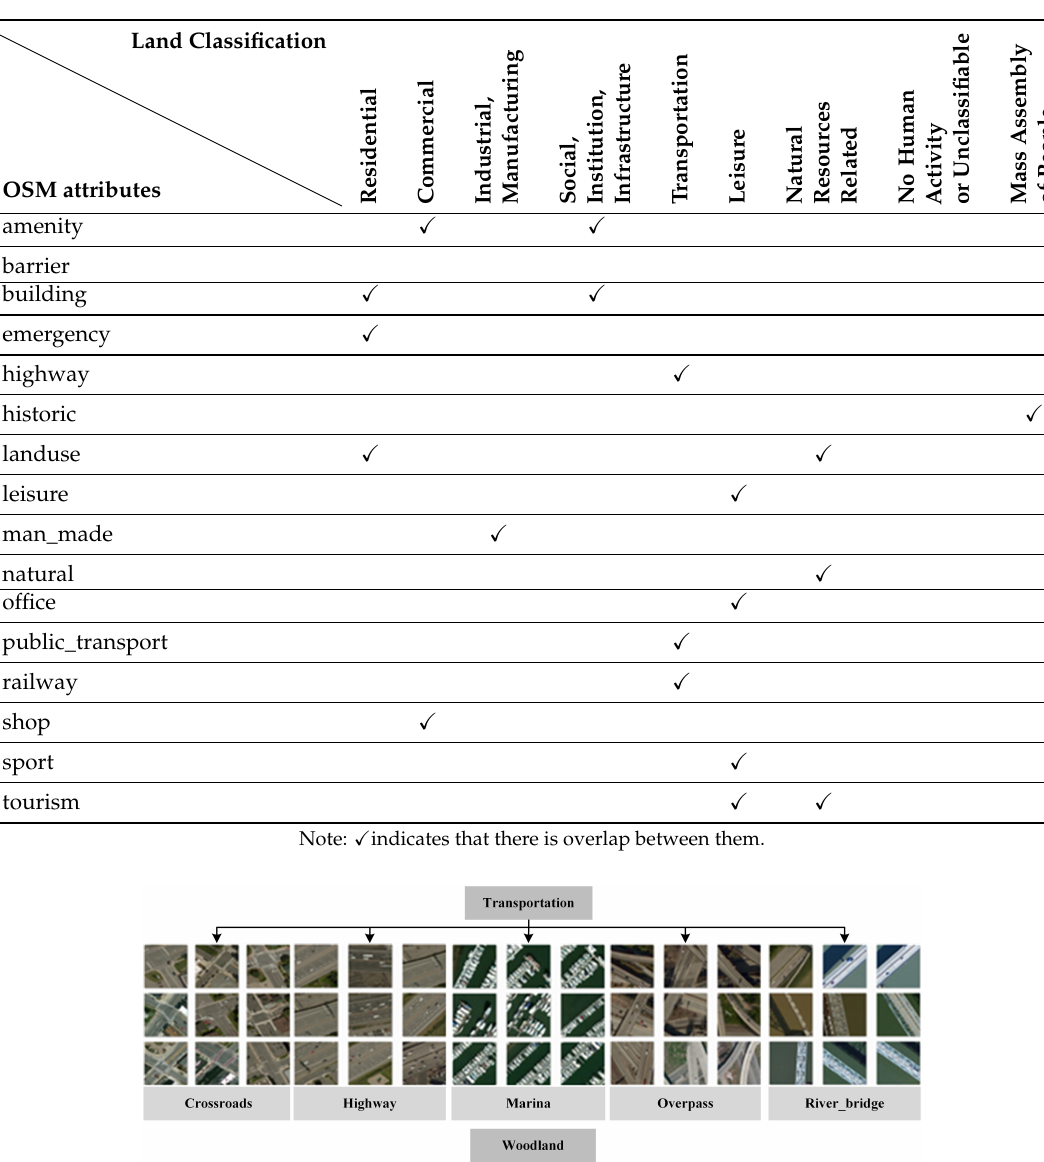
Table 2. Theintersecting categories between the Chinese land classification standard and POI. The vertical side of the table is the major class for OSM and the horizontal side is the land classification standard. Some OSM classes correspond to several categories in the land classification standard and vice versa.